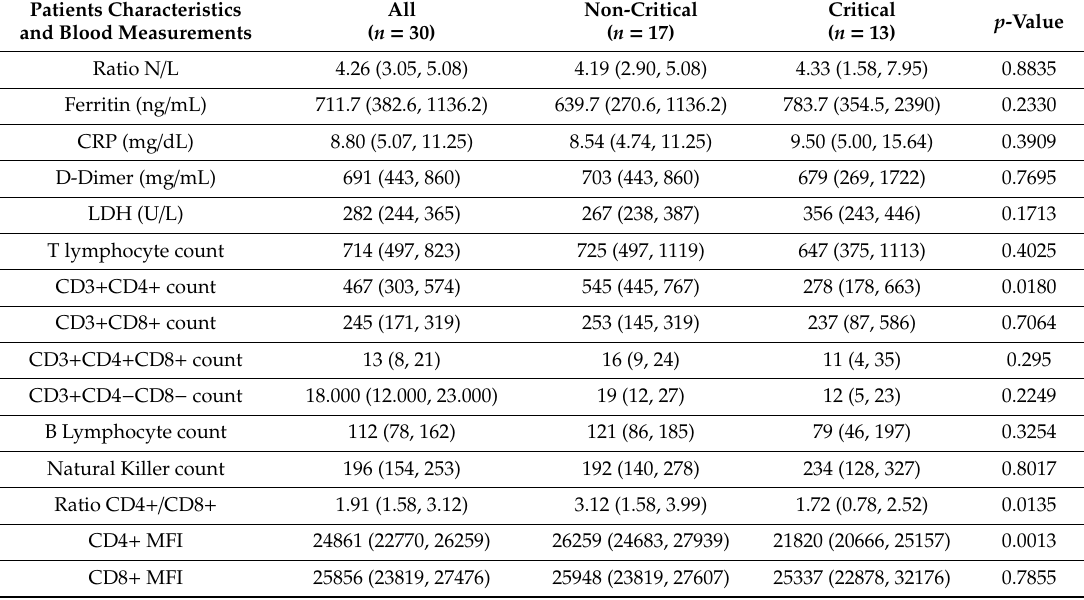
Patients Characteristics and Blood Measurements